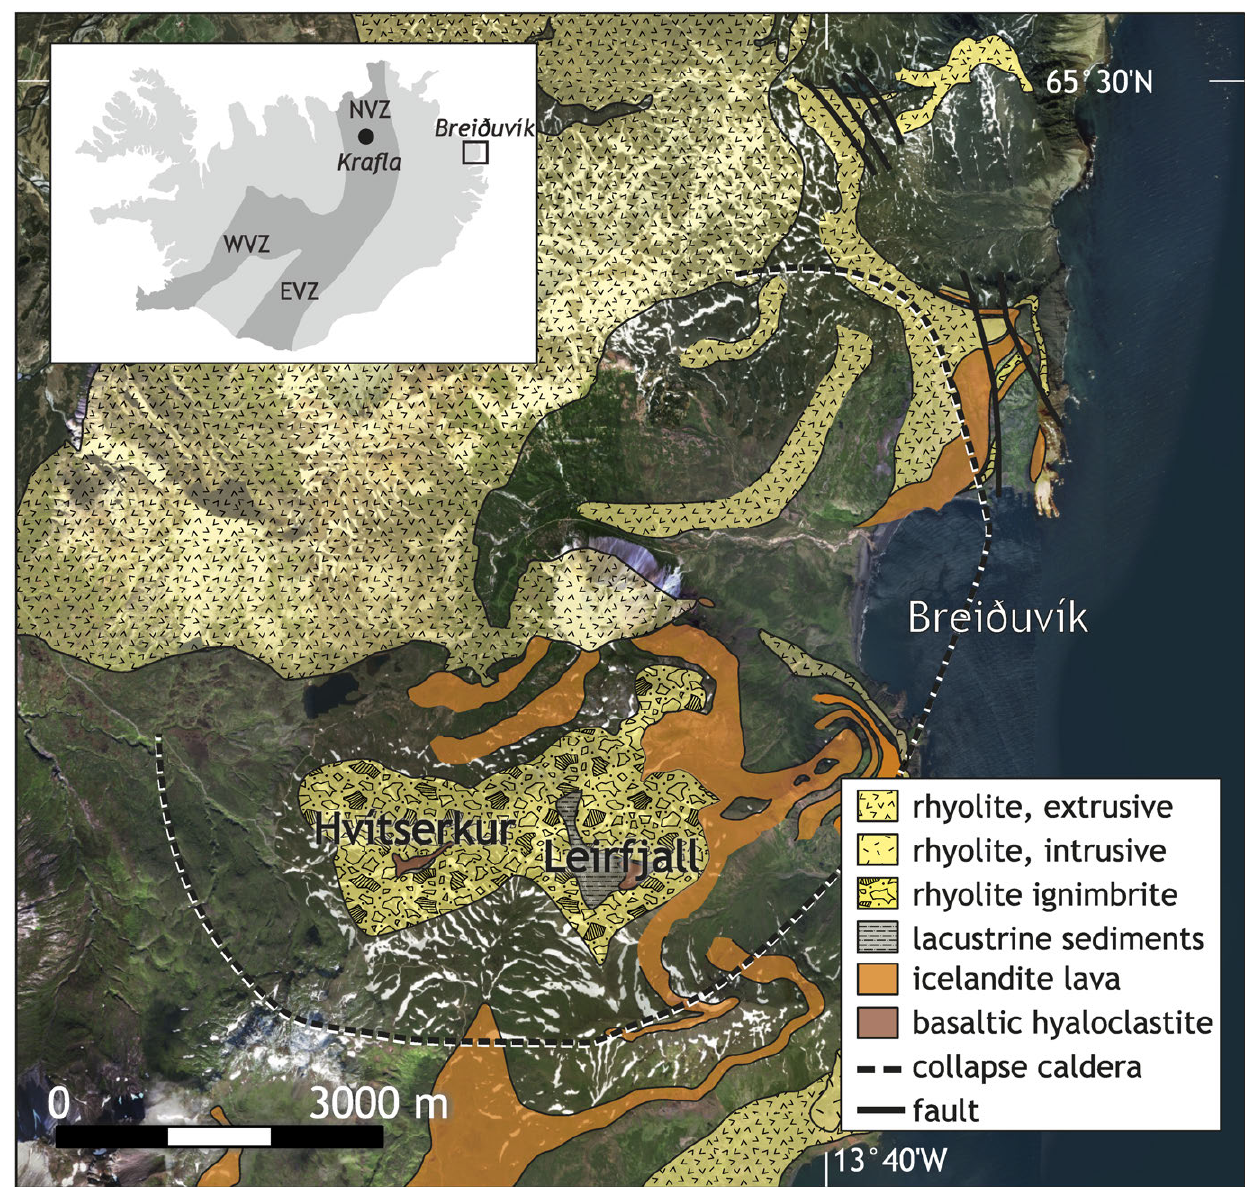
Figure 1: Geological map of the Breiðuvík caldera, East Iceland showing the location of the mountains Hvítserkur and Leirfjall. Background satellite image from Google Earth. The inset shows a map of Iceland with the location of the active volcanic zones (VZ in the N, W, and E) in dark grey shading, as well as the location of Krafla volcano and Breiđuvík caldera map. Map modified from Burchardt et al.